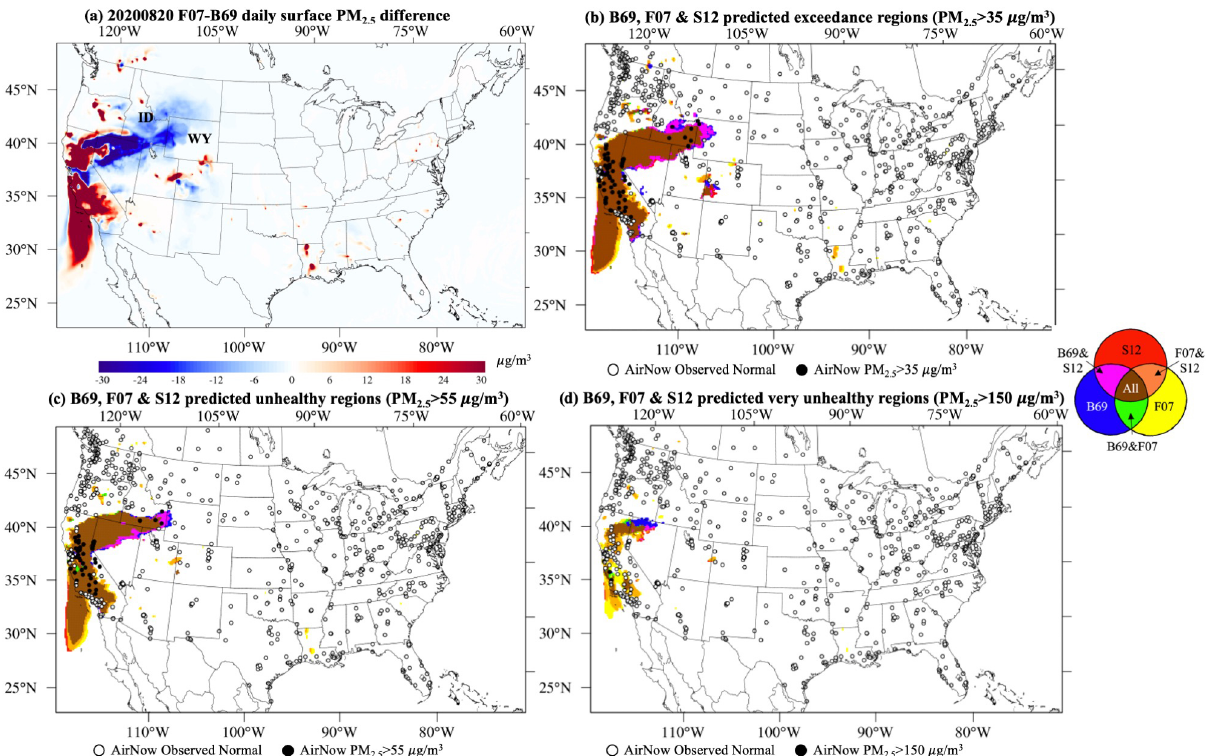
Figure 11. Predicted surface PM 2 . 5 concentrations above unhealthy levels by the S12, F07, and B69 runs for 20 August 2020. (a) The daily mean surface PM 2 . 5 difference between F07 and B69 runs. (b) Simulated PM 2 . 5 exceedance regions by B69, F07, and S12 overlaid by AirNow observed exceedance (PM 2 . 5 > 35µgm − 3 ). Panel (c) is the same as panel (b) but for U.S. EPA-defined unhealthy regions (PM 2 . 5 > 55µgm − 3 ). Panel (d) is the same as panel (b) but for U.S. EPA-defined very unhealthy regions (PM 2 . 5 > 150µgm − 3 ). The brown color represents the region where the runs with all three schemes simulate PM 2 . 5 exceedances. The blue (red/yellow) color represents the region where only B69 (S12 or F07) simulates the PM 2 . 5 exceedance. The green color represents the region where both the B69 and F07 simulate the PM 2 . 5 exceedance. The magenta color represents the region where both the B69 and S12 simulate the PM 2 . 5 exceedance. The orange color represents the region where both F07 and S12 simulate the PM 2 . 5